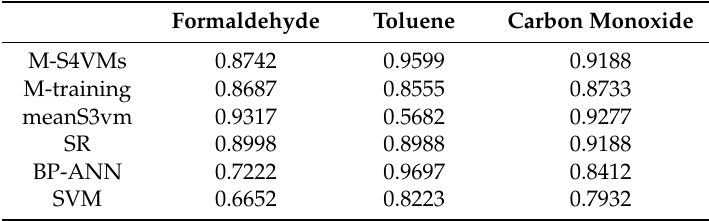
Table 11. Outcomes of the classification rates of target